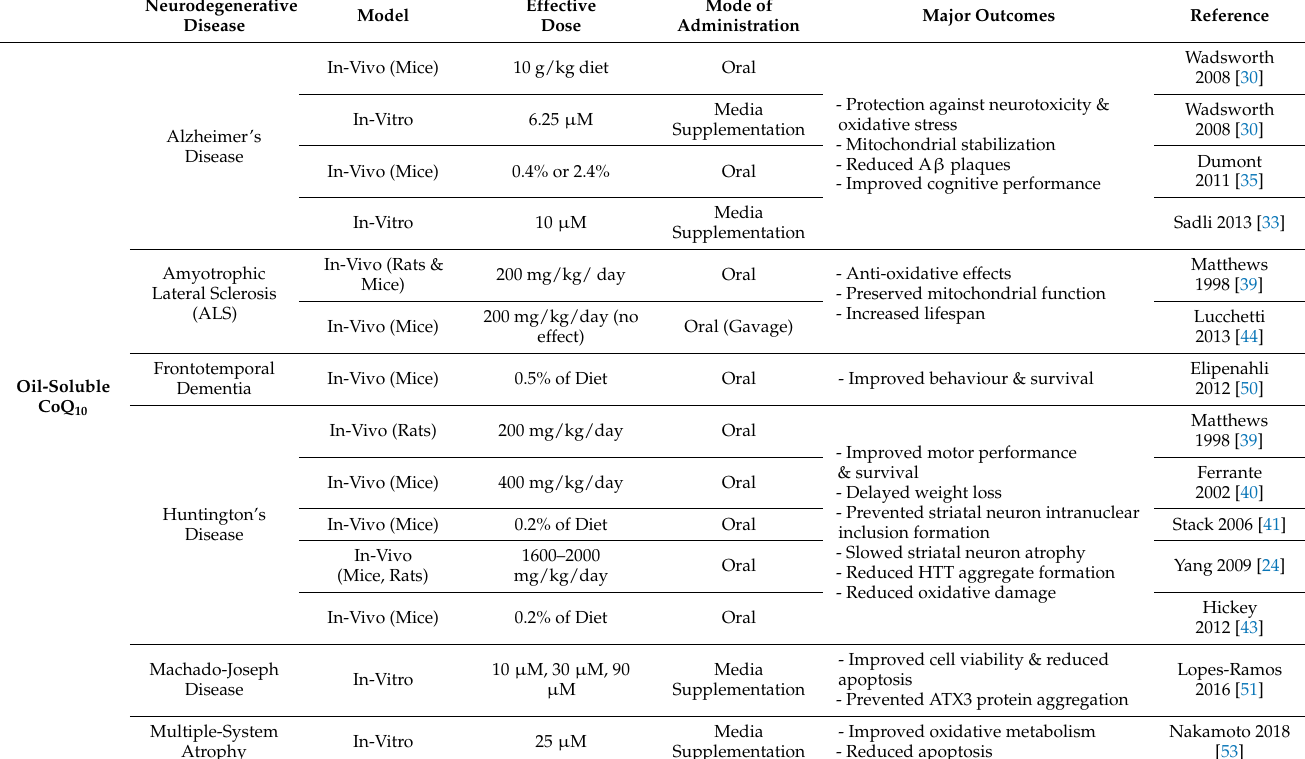
Table 1. Summary of recent research progress made with various formulations of coenzyme-Q